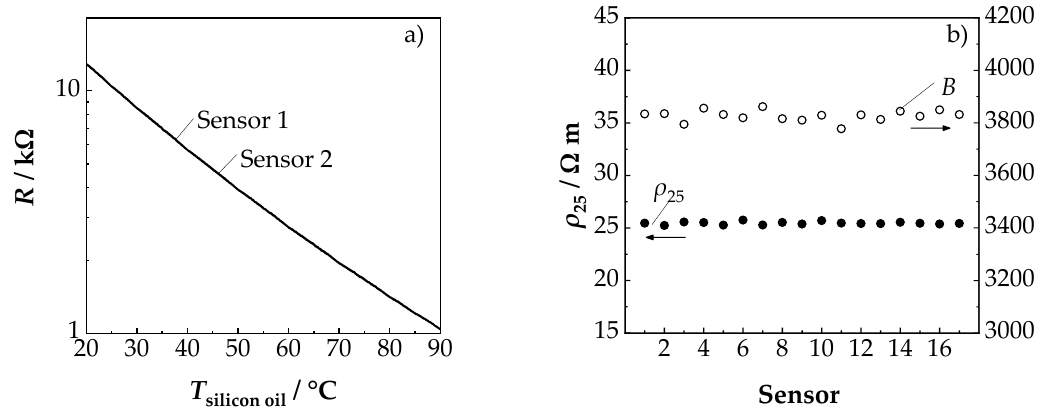
Figure 5. ( a ) R - T characteristics of two randomly chosen sensors (number 1 and 2 from Figure 5b) and ( b ) determined B and ρ 25 values of all 17 produced sensors.